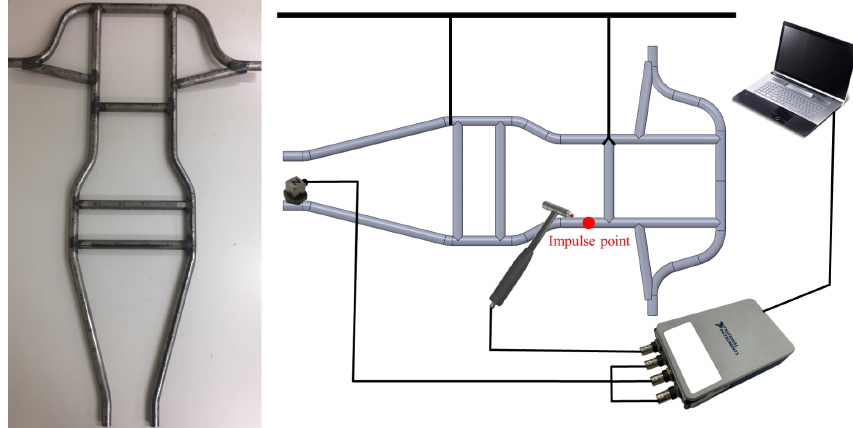
Figure 23. Schematic diagram of the frame structure entity and experiment.